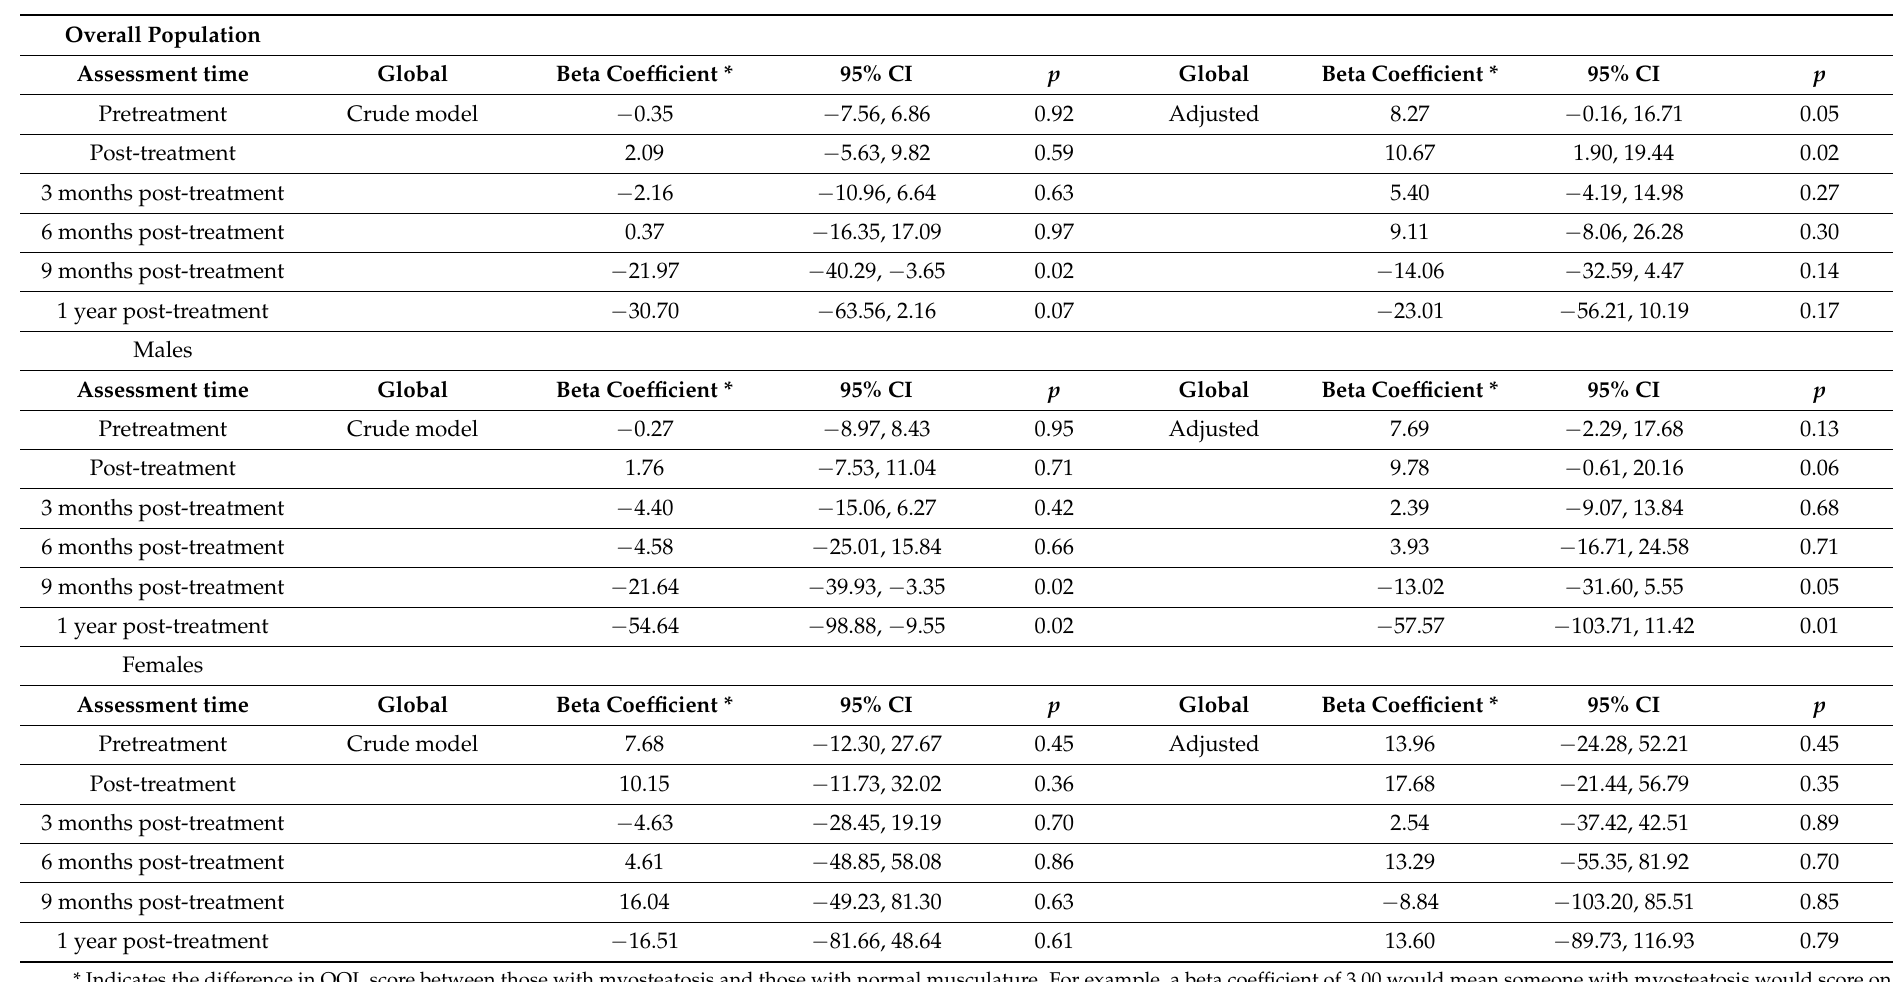
Table 3. Average difference in Global QOL score comparing those with myosteatosis to those with normal skeletal muscle density from pretreatment to one year after treatment. Overall Population Assessment